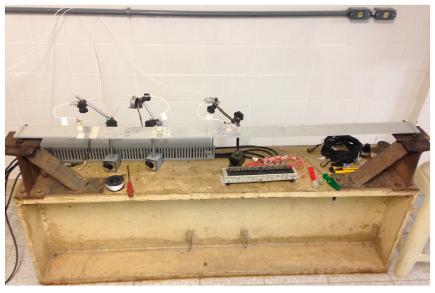
Figure 2: Experimental setup.